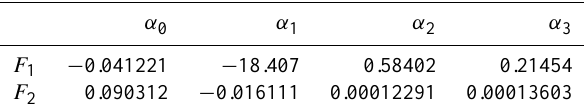
Table 2. Polynomial coefficients for the calculation of the brine volume (Lepp¨aranta and Manninen,